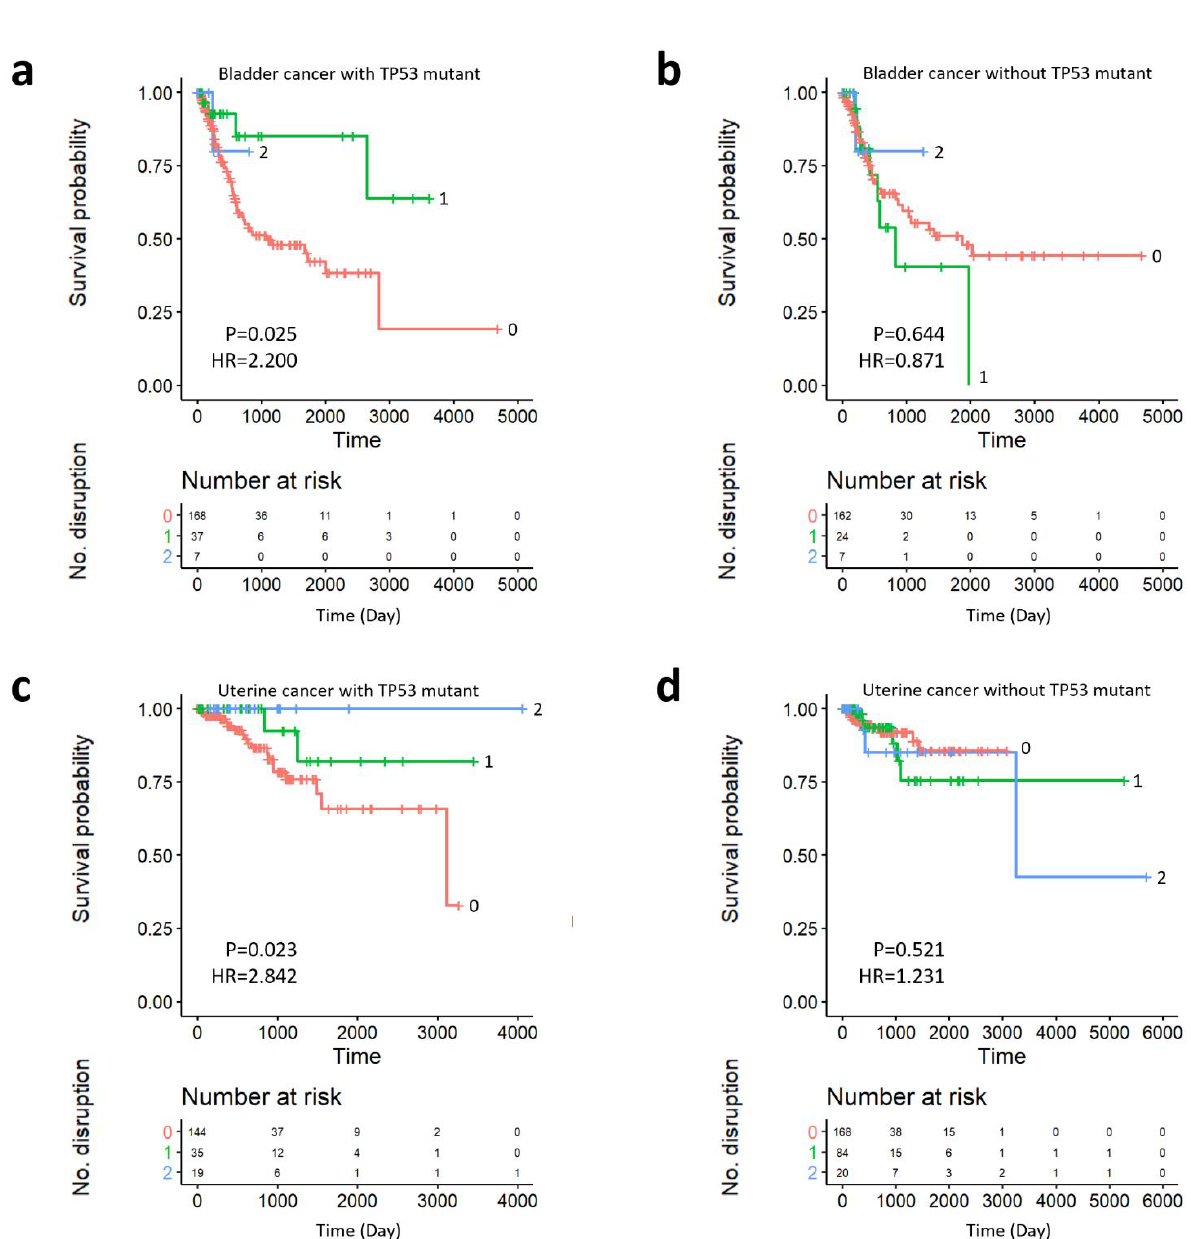
Figure 7. Kaplan–Meier graph for cumulative disruption of SYNE2 and SON, without the TP53 mutation. Red lines denote wild-type SYNE2 and SON, green lines represent mutation in one of the genes, and blue lines represent the disruption of both genes. ( a ) Patients with bladder cancer with a TP53 mutation. ( b ) Patients with bladder cancer without a TP53 mutation. ( c ) Patients with uterine cancer with a TP53 mutation. ( d ) Patients with uterine cancer without a TP53 mutation.